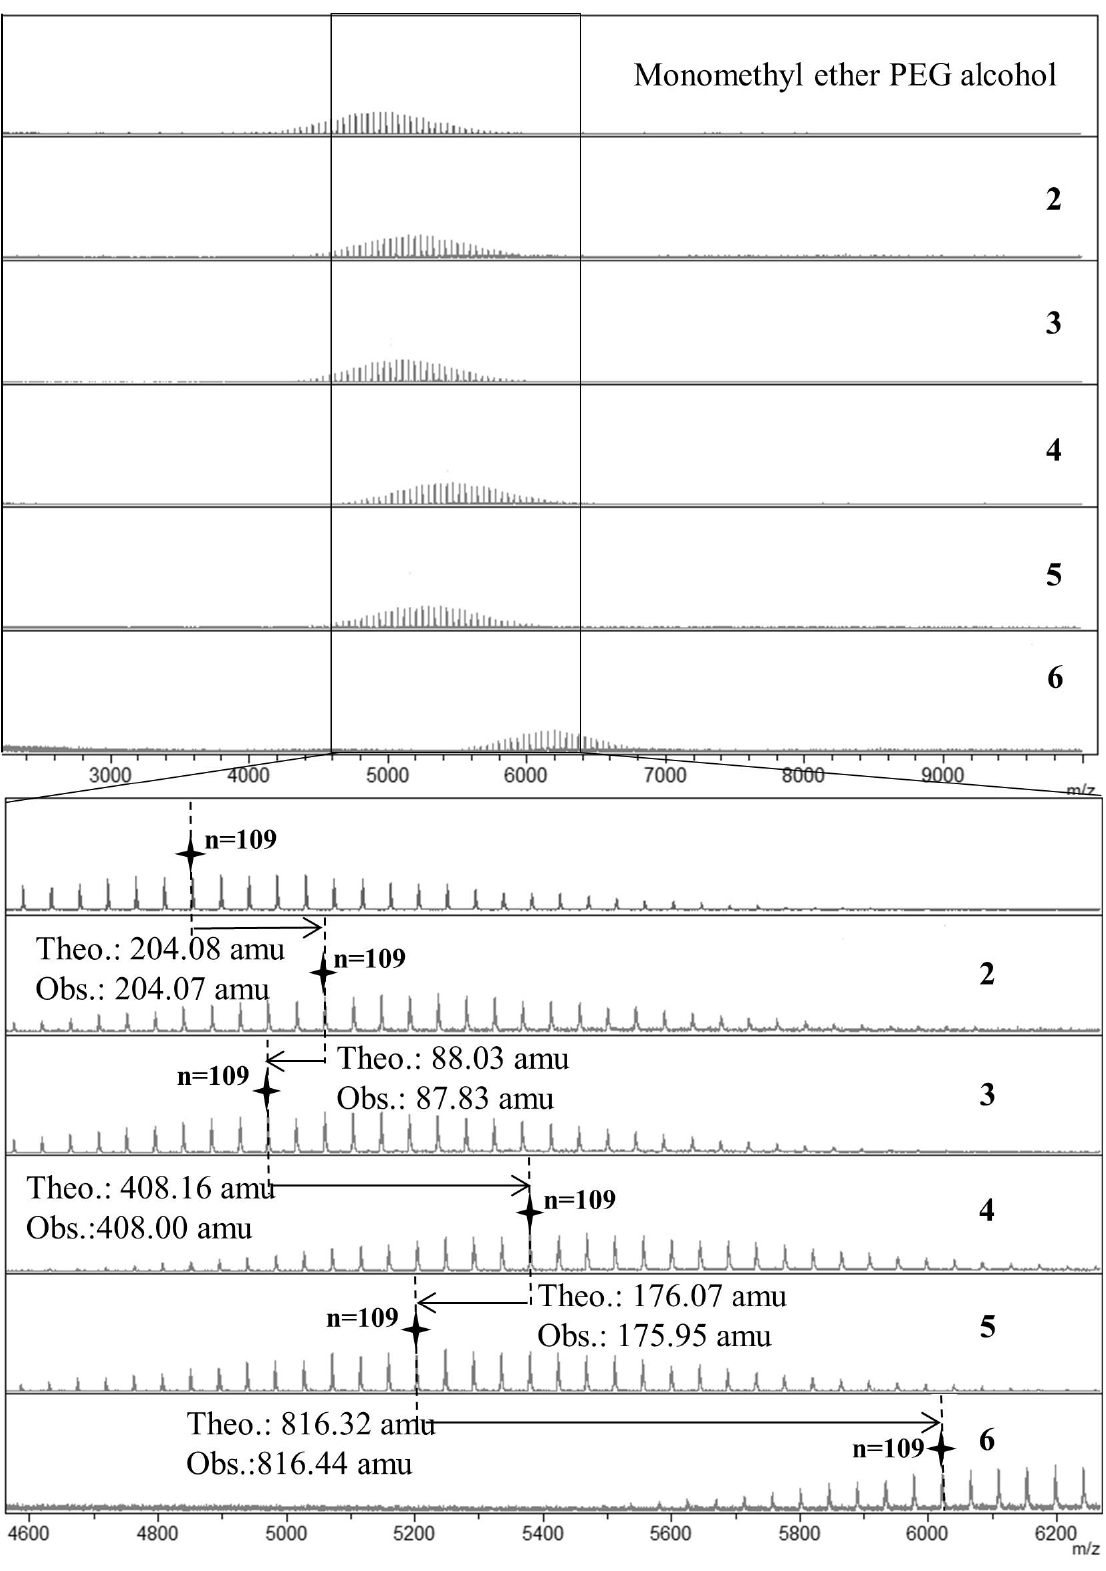
FIGURE 6 - MALDI-ToF mass spectra of the monomethyl ether PEG alcohol after each reaction (starting material and compounds 2-6). Monintoring the dendritic growth for a polymer with 109 repeat units is highlighted to demonstrate the accuracy and utility of MALDI-ToF MS as a characterization